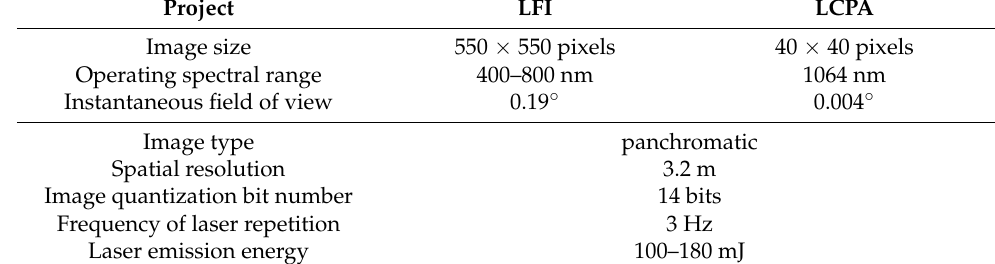
Table 1. Comparison of laser footprint image (LFI) and laser center profile array (LCPA) parameters.